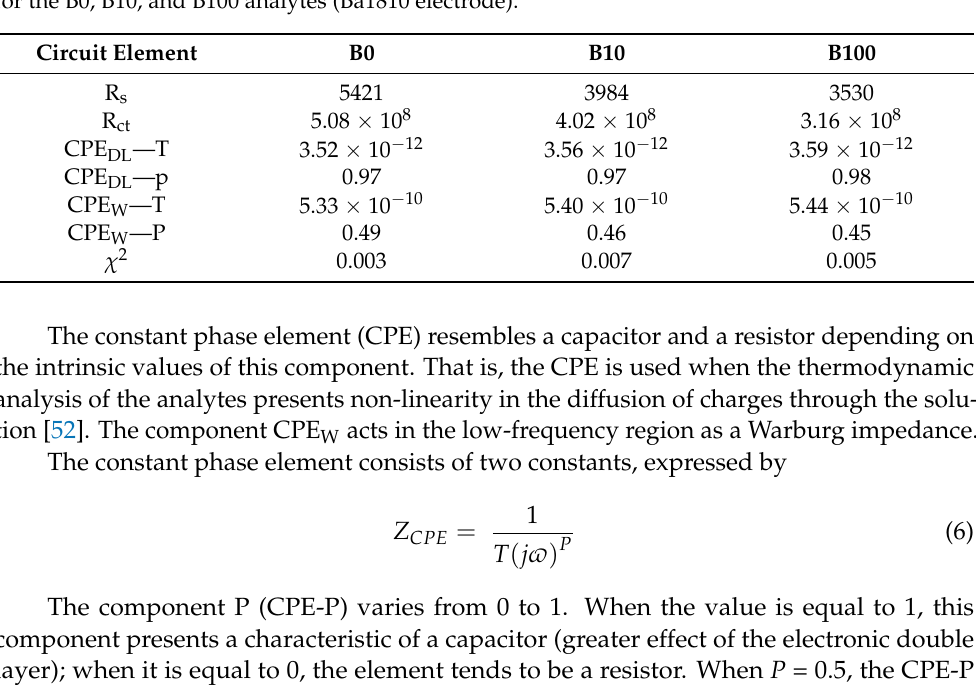
Figure 13. Adjustment of the proposed equivalent circuit for the pseudo-binary mixture of biodiesel–diesel. Table 2. Values obtained after adjustments made based on the proposed equivalent electrical circuit for the B0, B10, and B100 analytes (Ba1810 electrode).